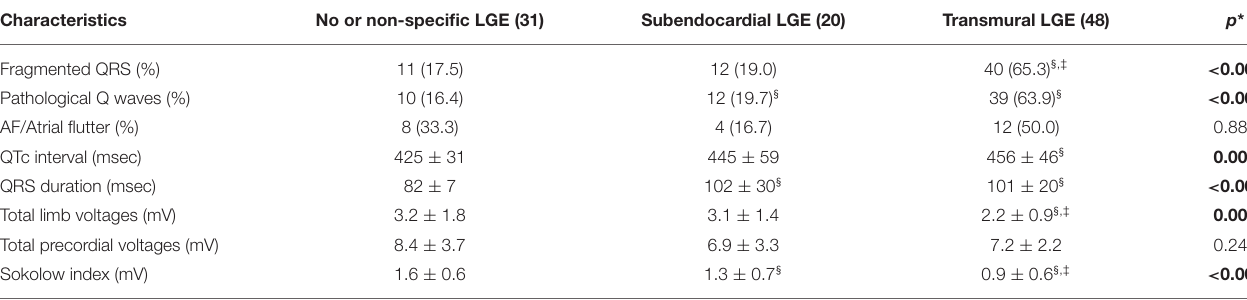
TABLE 2 | ECG parameters among the three patterns of late gadolinium enhancement (LGE). Characteristics